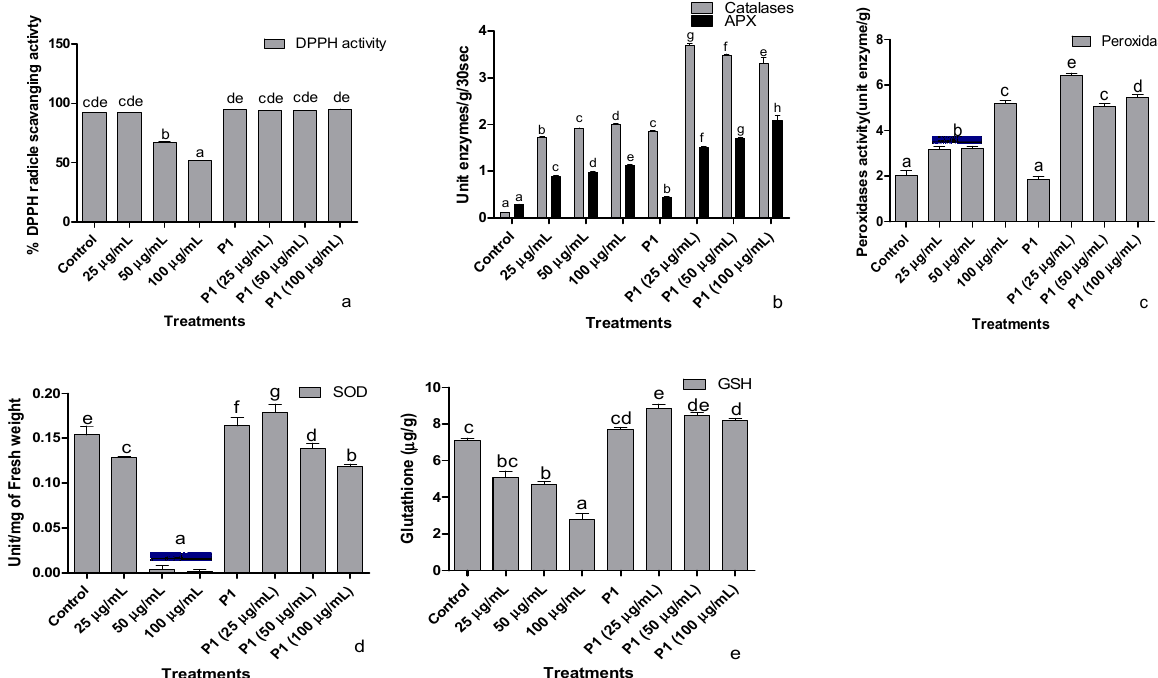
Figure 5. Effect of different concentrations of hexavalent chromium and P1 on ( a ) %DPPH radical scavenging activity, ( b ) catalases and ascorbate peroxidase, ( c ) peroxidase, ( d ) superoxide dismutase, and ( e ) reduced glutathione of sunflower seedlings grown hydroponically (half-strength Hoagland’s solution) for 16 days in a plant growth chamber. Data are mean of 36 replicates with SE of the mean. Different labels on mean bars represent significance (Duncan; p < 0.05).